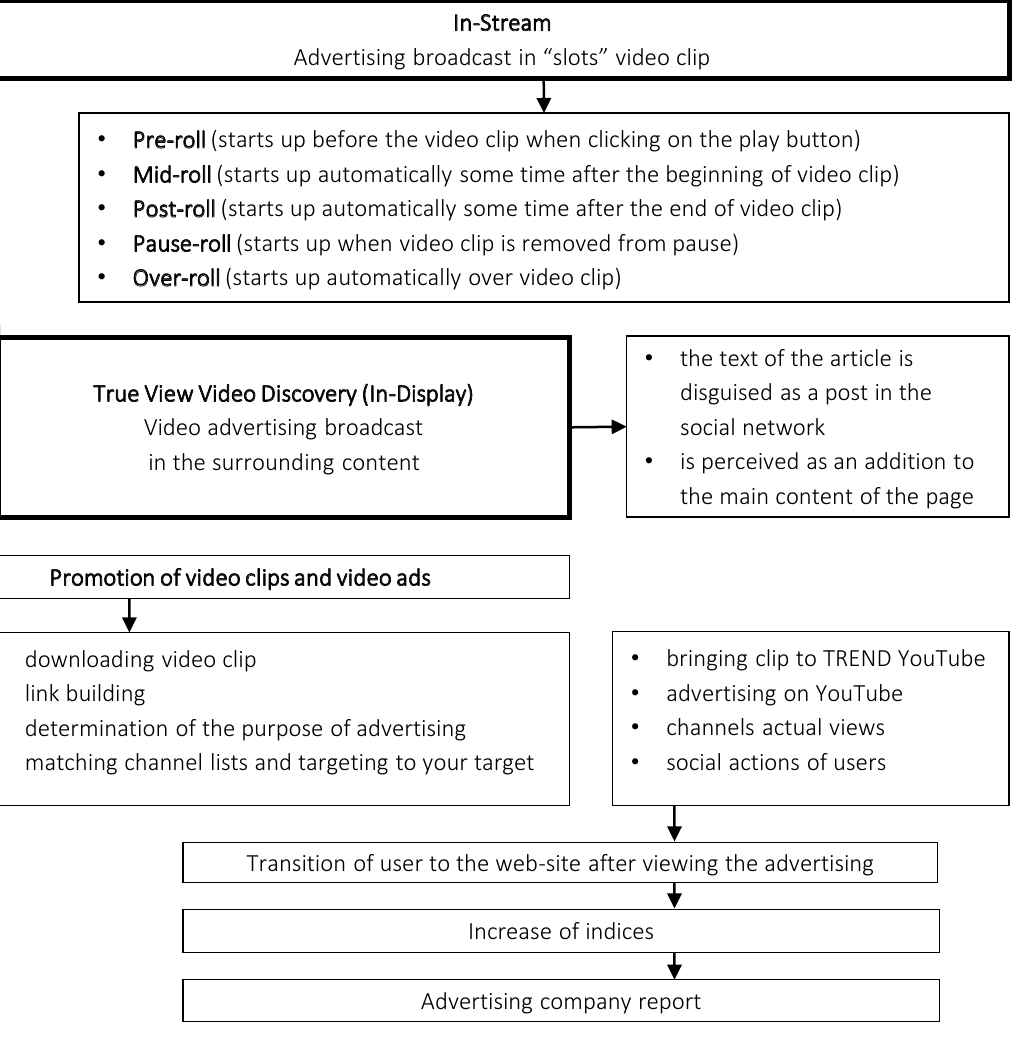
Figure 1. Structural chart of the production process from launching the video advertising-to-advertising company